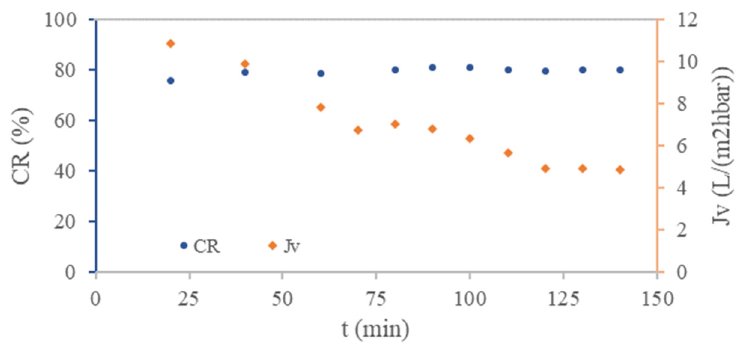
Figure 3. Conductivity rejection (CR) and permeance (Jv) in the function of time ( t ) for the recycled NF membrane.